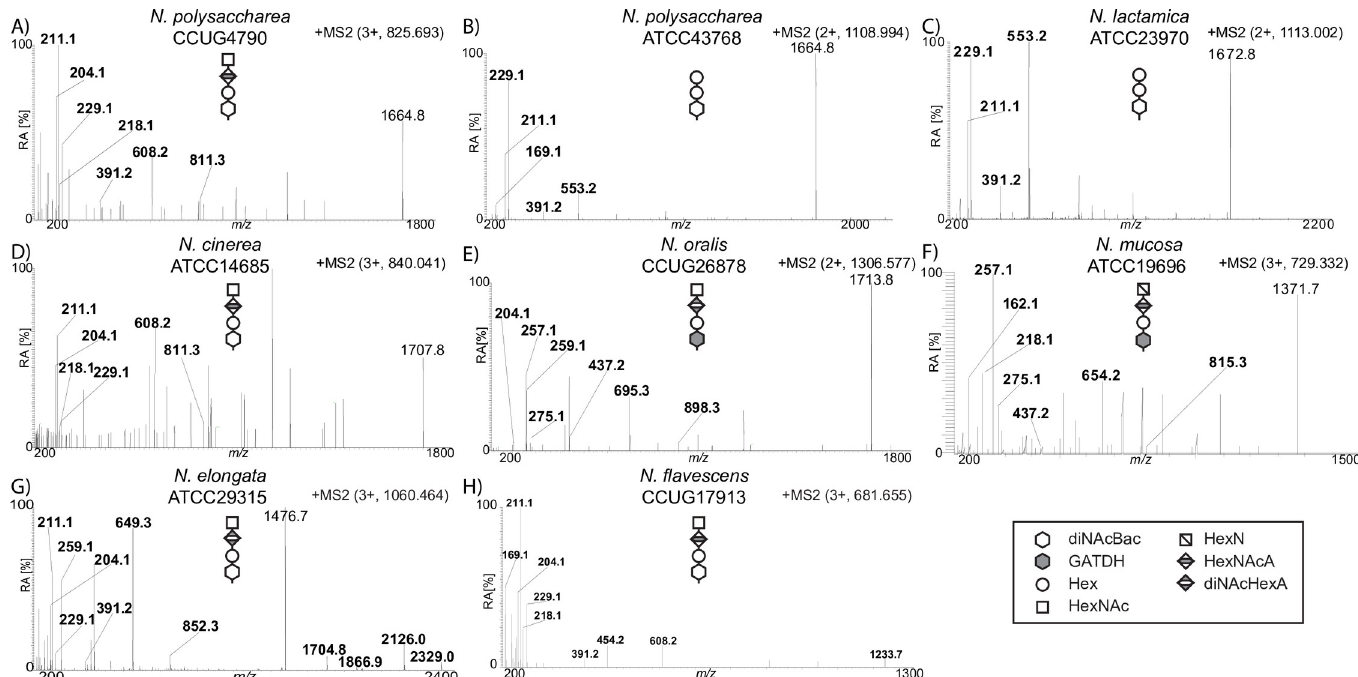
Fig 4. Targeted MS analysis of glycan structures shows presence of HexNAc/HexN incorporating glycoforms in select commensal strains. The reporter ions for the protein attached glycans are: diNAcBac at m/z 229.1/211.1, diNAcBac-Hex at m/z 391.2, diNAcBac-Hex-Hex at m/z 553.2, diNAcBac-Hex-HexNAcA at m/z 608.2, diNAcBac-Hex-diNAcHexA at m/z 649.3, diNAcBac-Hex-HexNAcA-HexNAc at m/z 811.3, diNAcBac-Hex-diNAcHexA-HexNAc at m/z 852.3. GATDH at m/z 275.1/ 257.1, GATDH-Hex at m/z 437.1, GATDH-Hex-HexNAcA at m/z 654.2, GATDH-Hex-diNAcHexA at m/z 695.3, GATDH-Hex-HexNAcA-HexN at m/z 815.3, GATDH-Hex-diNAcHexA-HexNAc at m/z 852.3, HexN at m/z 162.1, HexNAc at m/z 204.1, HexNAcA at m/z 218.1 and diNAcHexA at m/z 259.093. A) MS2 spectrum of a glycopeptide carrying a diNAcBac-Hex-HexNAcA-HexNAc from N . polysaccharea CCUG4790. B) MS2 spectrum of a glycopeptide carrying a diNAcBac-Hex-Hex from N . polysaccharea ATCC43768. C) MS2 spectrum of a glycopeptide carrying a diNAcBac-Hex-Hex from N . lactamica ATCC23970. D) MS2 spectrum of a glycopeptide carrying a diNAcBac-Hex-HexNAcA-HexNAc from N . cinerea ATCC14685. E) MS2 spectrum of a glycopeptide carrying a GATDH-Hex-diNAcHexA-HexNAc from N . oralis CCUG26878. F) MS2 spectrum of a glycopeptide carrying a GATDH-Hex-HexNAcA-HexN from N . mucosa ATCC19696. G) MS2 spectrum of a glycopeptide carrying a diNAcBac-Hex-diNAcHexA-HexNAc from N . elongata ATCC29315. H) MS2 spectrum of a glycopeptide carrying a diNAcBac-Hex-HexNAcA-HexNAc